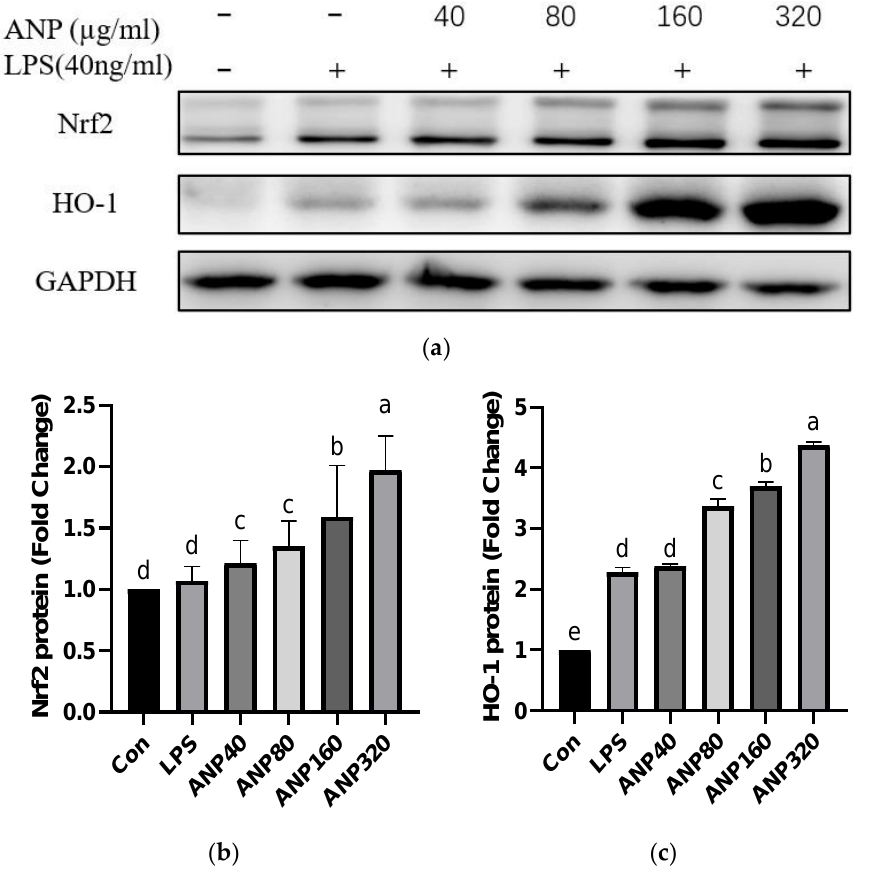
Figure 3. ANP enhancement of the Nrf2 and HO-1 proteins: ( a ) Nrf2 and HO-1 were detected by Western blot and GAPDH was used as a control; ( b , c ) the densitometric quantification of bands showing Nrf2 and HO-1. The results shown are presented as means ± SD ( n = 3). The different letters in the graph indicate significance ( p < 0.05).